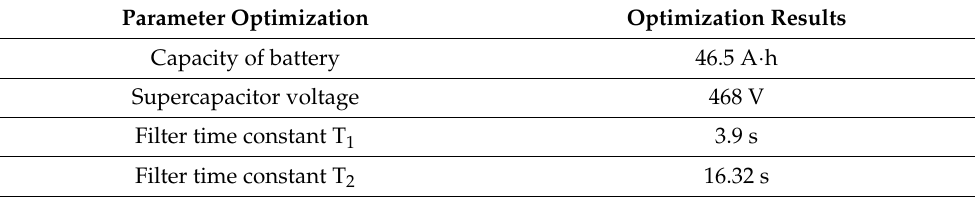
Table 3. Parameter optimization results.